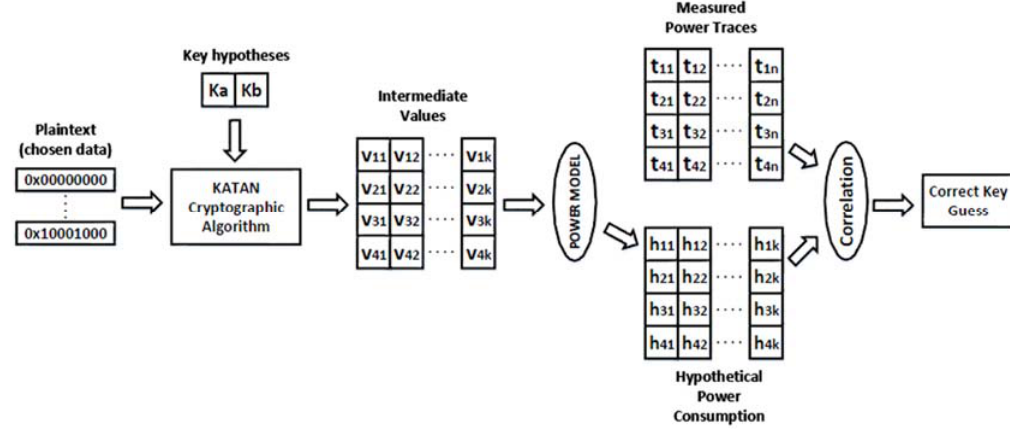
Figure 44. The power traces between TFET static XOR and CML XOR.